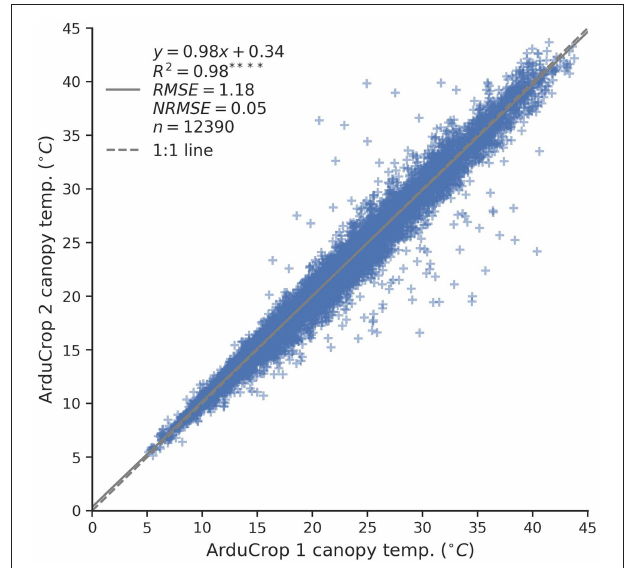
FIGURE 2 | Relationship between canopy temperature (CT) of duplicate ArduCrop sensors, denoted ArduCrop 1 and ArduCrop 2. Scatter plot comprising CT data from all 29 plots with fitted linear regression equation, coefficient of determination ( R 2 ), root mean square error (RMSE), normalized RMSE (NRMSE) and the number of values ( n ). Linear regression analysis for each individual plot is shown in Figure S2 and Table S1 .